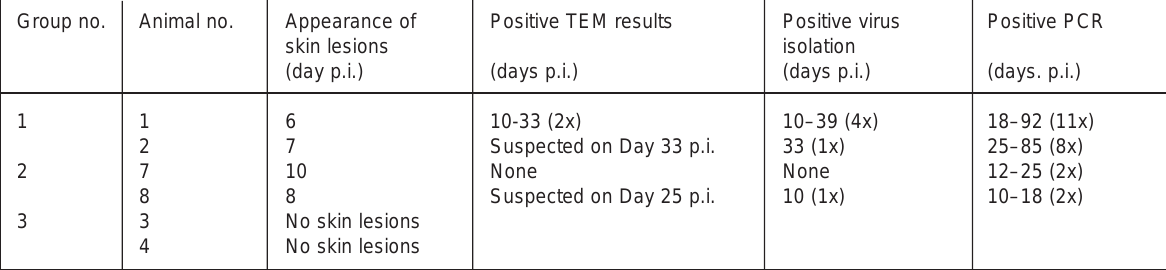
TABLE 5 Detection of LSD virus / nucleic acid in skin lesions using TEM, VI and PCR The numbers in brackets indicate the number of positive test results during the time period Group